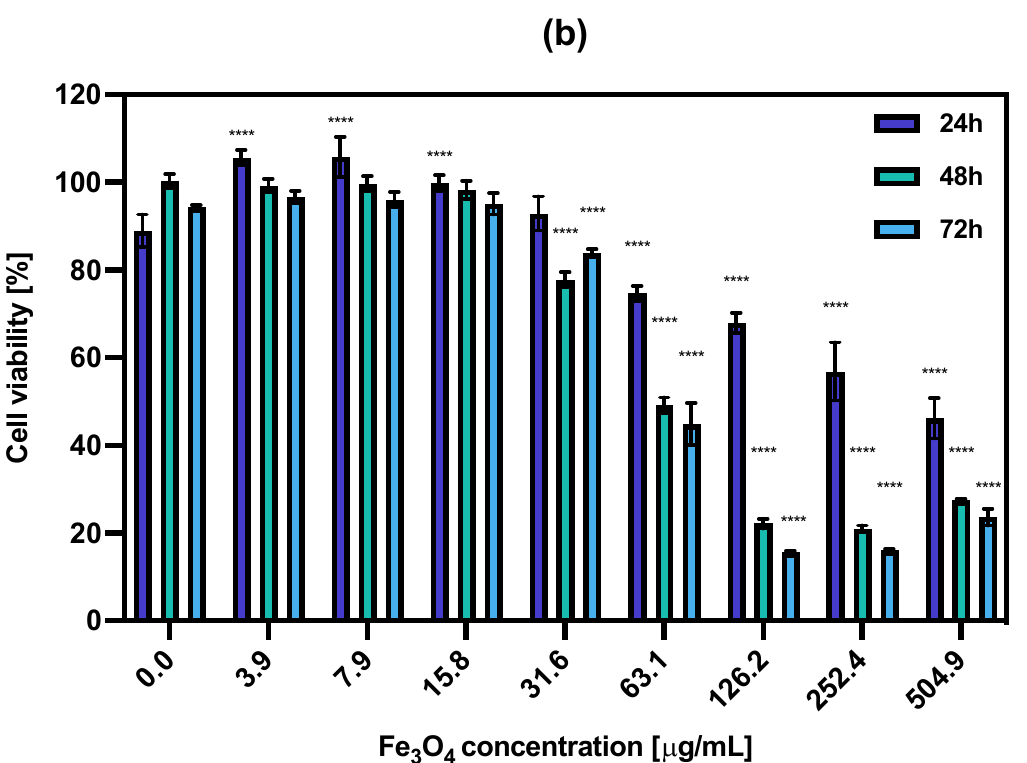
Figure 6. Cell viability after treatment with different concentrations of ( a ) NPs-PEG, ( b ) NPs-Tmab. SKOV-3 were incubated for 24, 48 and 72 h. The results are expressed as a percentage of control cells. Data are expressed as mean value ± SD ( n = 3). Statistical confidence was considered if p < 0.01 (**), p < 0.001 (***), p < 0.0001 (****). The calculated IC 50 values ranged from 326.1 μg/mL for 24 h incubation with NPs- PEG which was followed by 110.5 μg/mL and 91.08 μg/mL for 48 and 72 h, respectively. For the NPs-Tmab the calculated IC 50 was shown to be 353.9 μg/mL for 24 h and 73.09 and 63.04 μg/mL for 48 and 72 h incubation times. This indicates that the cytotoxicity of NPs- PEG was slightly lower than that obtained for NPs-Tmab for concentrations higher than